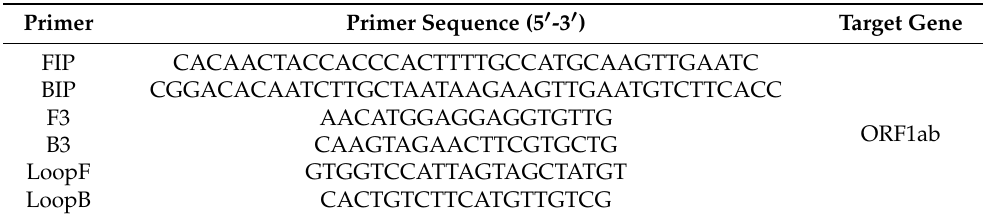
Table 5. LAMP assay primer